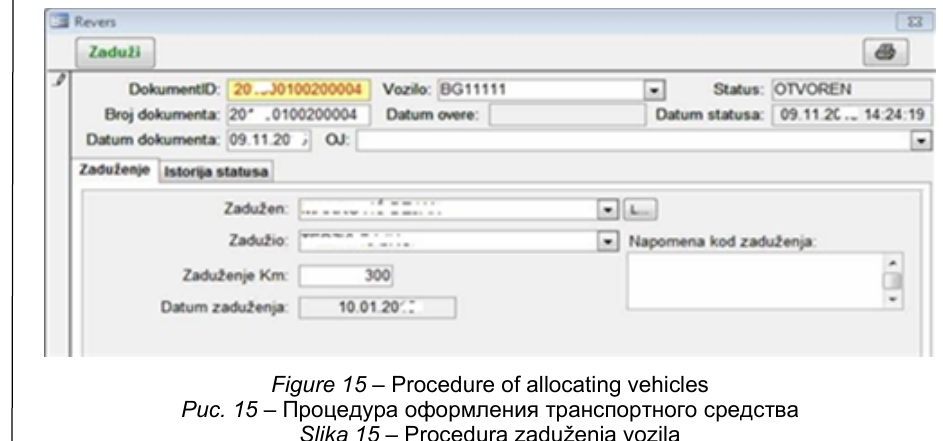
Figure 15 – Procedure of allocating